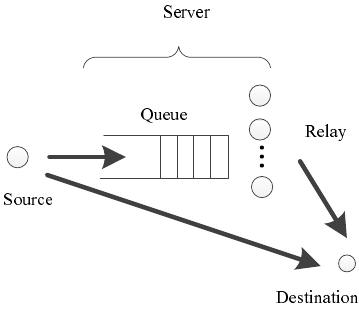
Figure 3. Queue in network for δ >